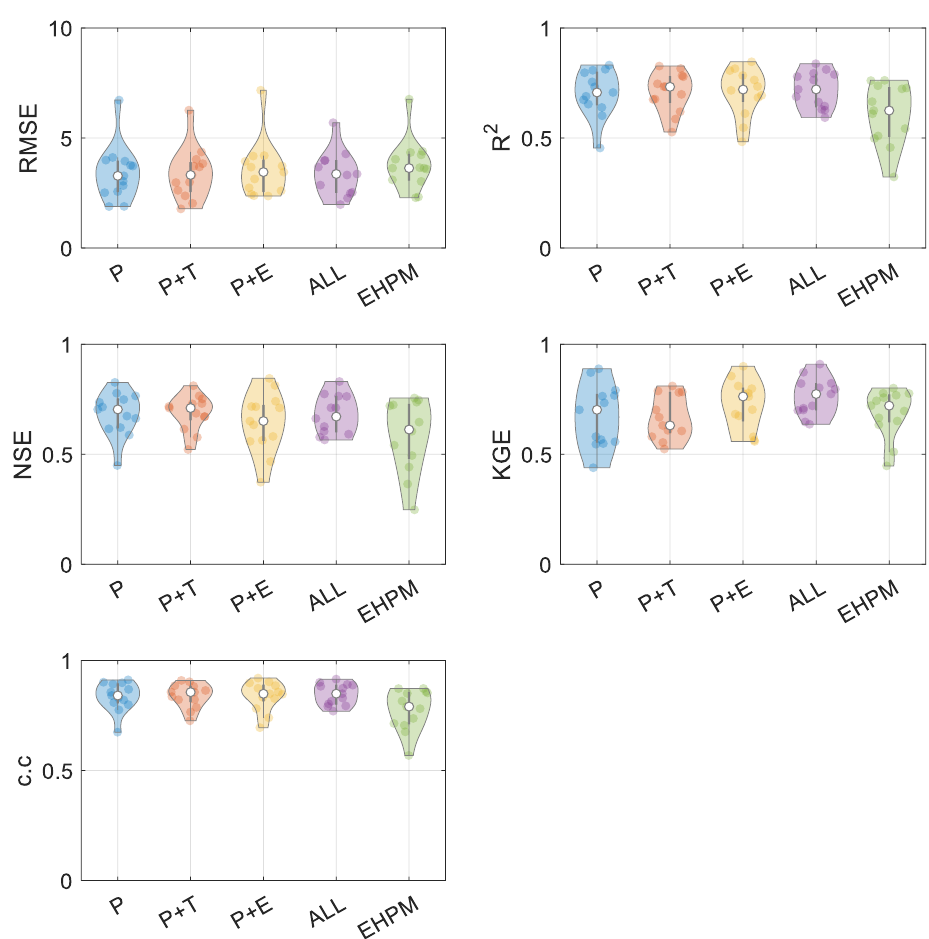
Figure 5. Summary of streamflow prediction performance during the test period (2012 to 2020). Here, P is the case where only rainfall is input, P+T is where rainfall and temperature are input, P+E is where rainfall and potential evapotranspiration are input, ALL is where all meteorological information is input, and EHPM is the benchmark model. Noted that circle markers are median values, and bars denote the first and third quartiles. Translucent dots are the results for each basin, and curved lines show the kernel density curves.